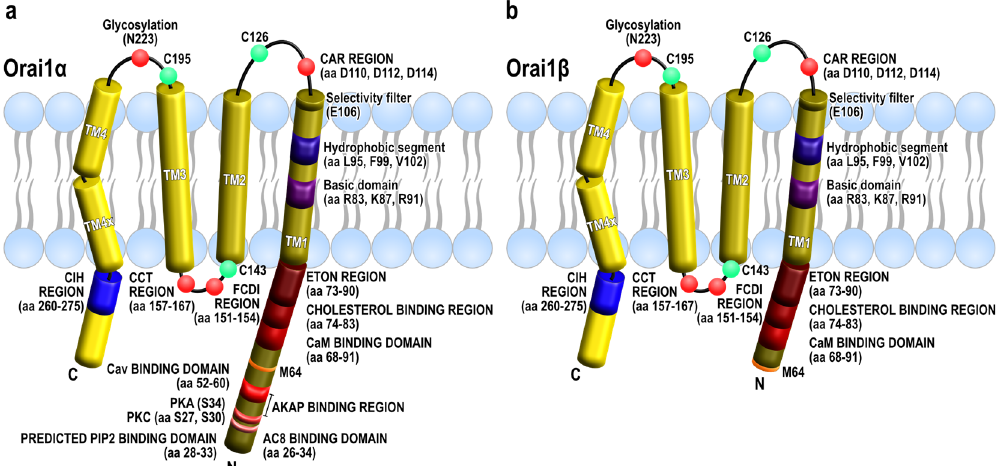
Figure 2. Cartoon depicting Orai1 α or Orai1 β relevant domains. Both variants of Orai1, Orai1 α ( a ) and Orai1 β ( b ), are presented with several key amino acids and domains required for their function and the association with other proteins. Abbreviations as they appear from the N – to the C – termini: AC8, adenylyl cyclase 8; PIP2, phosphatidylinositol bisphosphate; PKC, protein kinase C; PKA, protein kinase A, AKAP, A – kinase anchoring protein; Cav, caveolin; CaM, Calmodulin; ETON, extended transmembrane Orai1 N-terminal region; CAR, Ca 2+ accumulating region; C126, C143 and C195, cysteine residues that modulate the redox regulation of Orai1; FCDI, fast Ca 2+ -dependent inactivation; CCT, chaperonin – containing T – complex protein 1 chaperonin complex; CIH, C-terminus Internalization Handle; TM, transmembrane domain; TM4x, extended transmembrane domain 4.